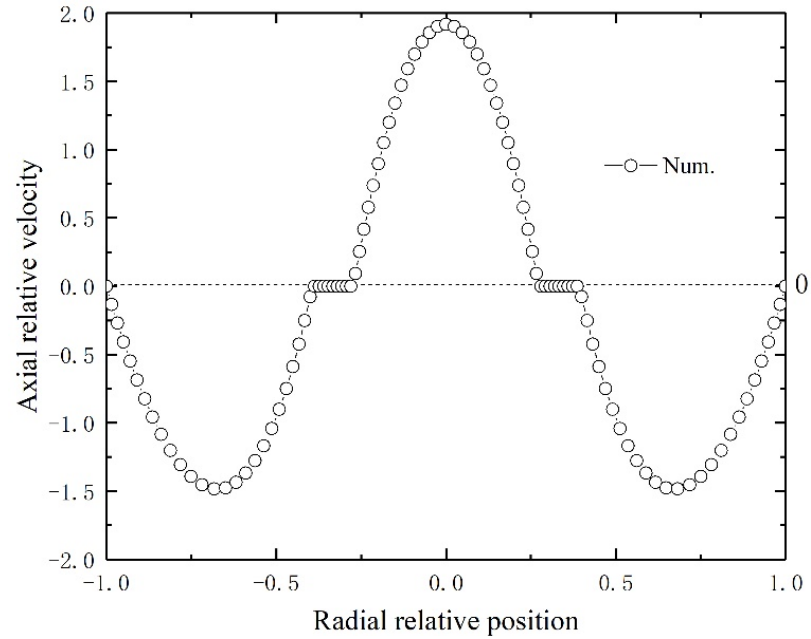
Figure 3. Axial relative velocity distribution in the membrane tube’s middle